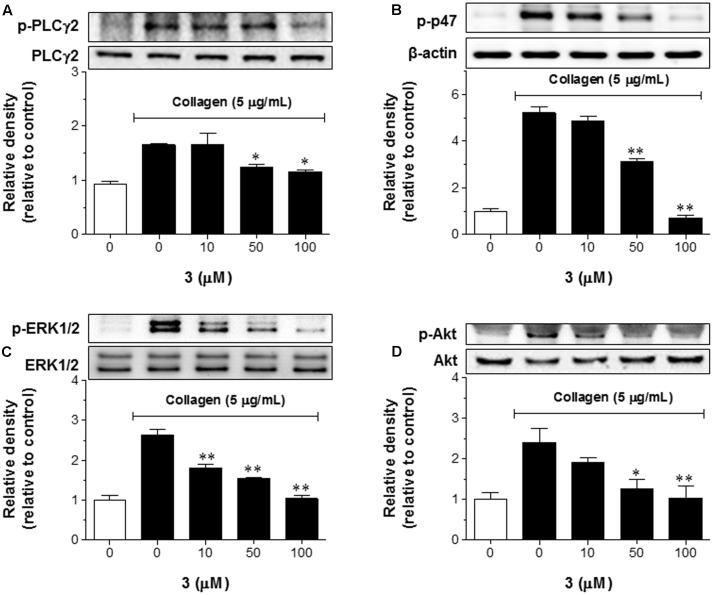
3 inhibits PLCγ2-mediated signaling pathway. (A–D) Washed rabbit platelets in CaCl2 (1 mM) were incubated with 3 (10–100 μM) or DMSO for 3 min followed by collagen (5 μg/mL) stimulation for 5 min. Cells were lysed and proteins were employed by SDS-PAGE following Western blotting using primary antibodies targeting anti-phospho PCLγ2 (A), anti-phospho p47 (B), anti-phospho ERK1/2 (C), and anti-phospho Akt (D). The data shown in bar graphs expressed as the means ± SEM are an average of three similar and independent experiments and the gel images are of representative blots. ∗p < 0.05, ∗∗p < 0.01 vs. control (collagen treatment, but no 3).